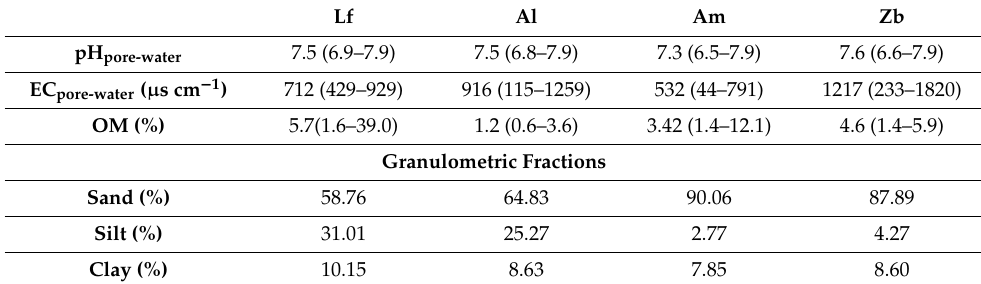
Table 1. Sediments main physicochemical characteristics (mean (min–max); n = 12), in the